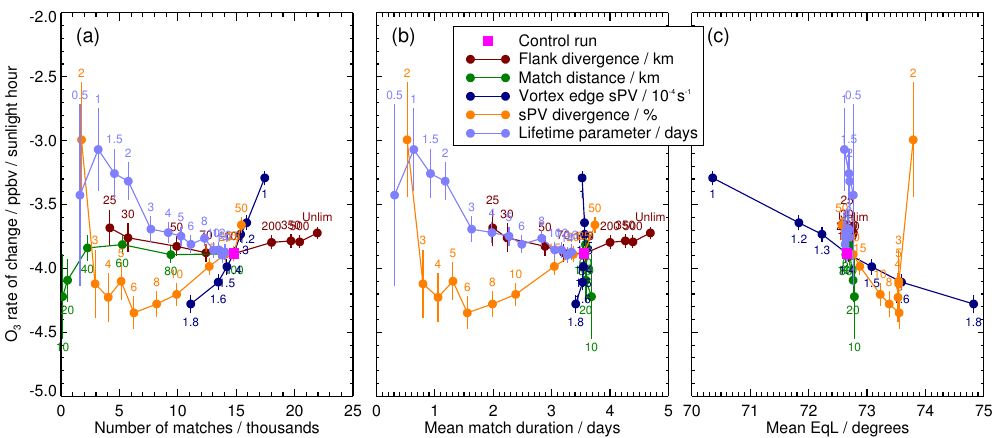
Figure 2. Arctic vortex-average ozone loss, estimated for the same altitude/day range as in Fig. 1, using the criteria given in the text (magenta square symbols), and estimated using various perturbed criteria (colored circles and lines, with colors defined in the legend). The three panels show the inferred ozone loss vs. (a) number of matches, (b) mean match duration, and (c) mean sPV for all the points along the match trajectories. Annotations above or below each colored point give the corresponding value of the perturbed criterion (units are given in the legend, “Unlim” indicates the case with the flank divergence criterion ignored). Error bars show the precision estimated by the Lehmann et al. (2005) approach (see